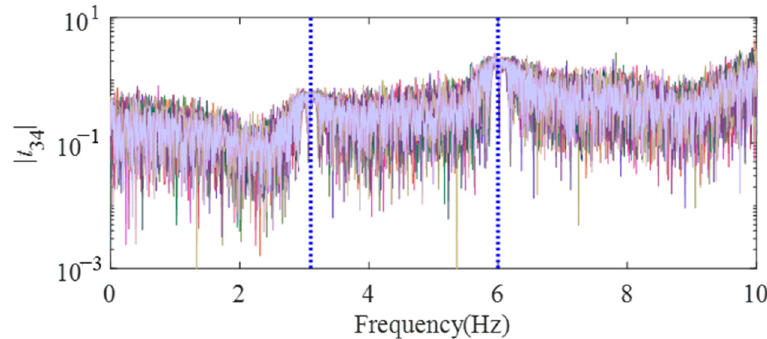
Figure 8. Delayed TRF